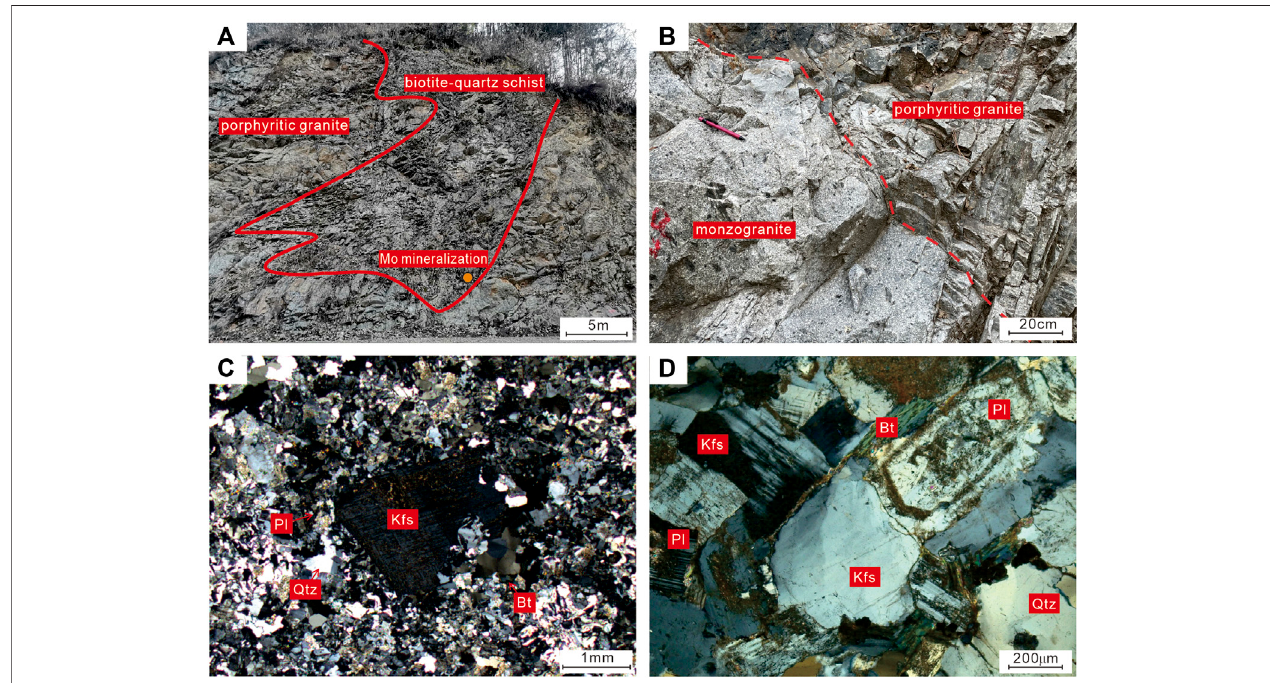
FIGURE 2 | Photos and microstructures of Yaozhuang stock. (A) Porphyritic granite intruded into biotite quartz schist; (B) monzogranite vein intruded into porphyritic granite; (C) porphyritic granite (orthogonal polarization); (D) monzogranite (orthogonal polarization); Kfs — K-feldspar, Pl — plagioclase, Qtz — quartz, Bt — biotite; γπ J 3 — Late Jurassic porphyritic granite; ηγ J 3 — Late Jurassic monzogranite; Pt 2-3 sc — Middle-Upper Proterozoic Sichakou rock formation.